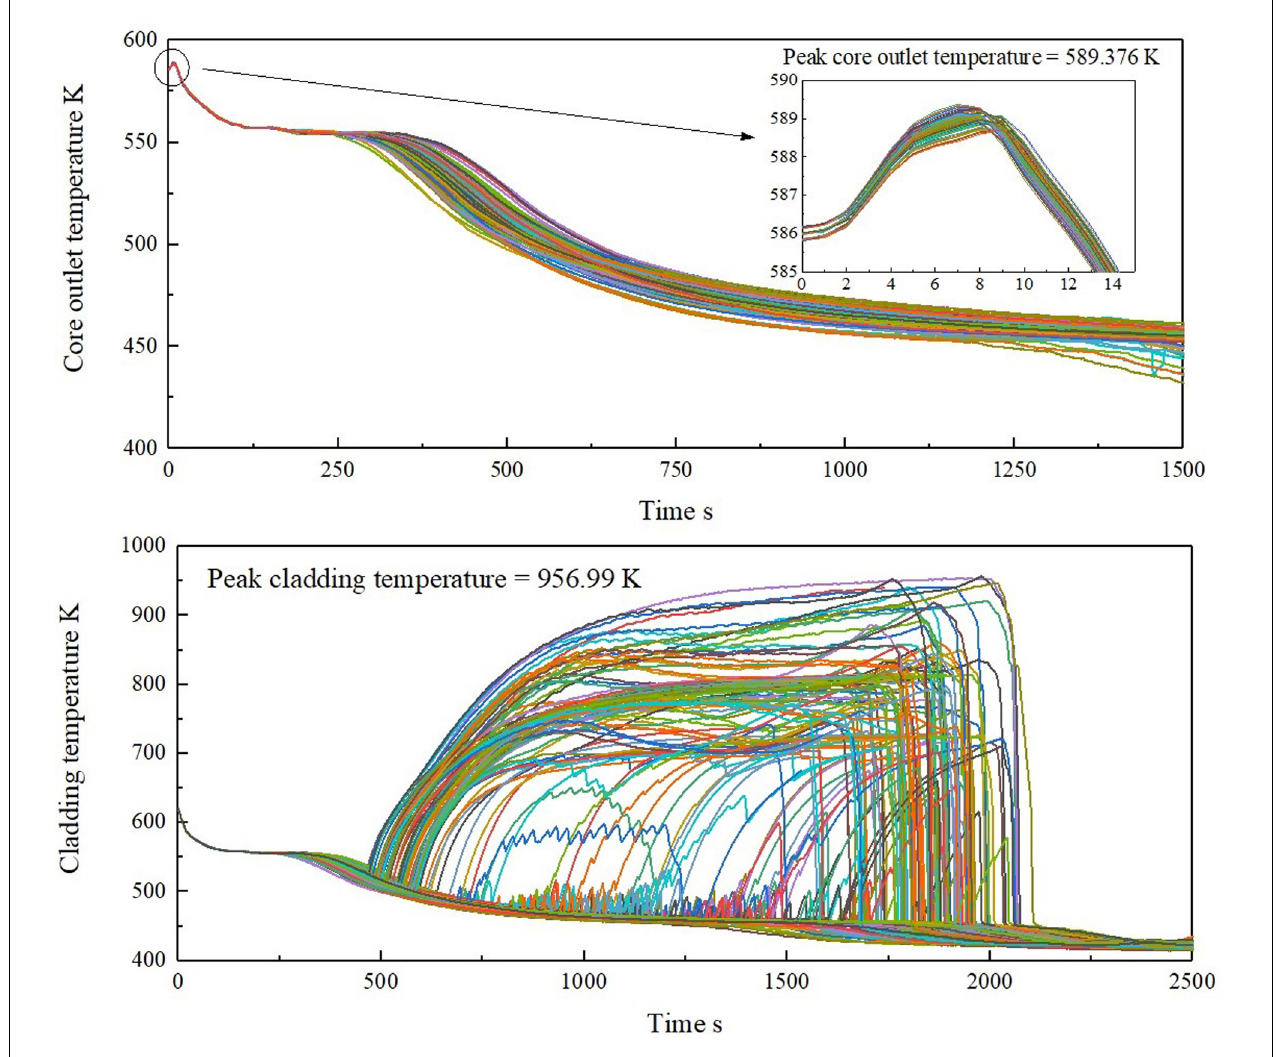
FIGURE 12 | Uncertainty results of figures of merit (FOMs) with traditional best estimate plus uncertainty (BEPU) method. (A) Results of the peak core outlet temperature. (B) Results of the peak cladding temperature (PCT).